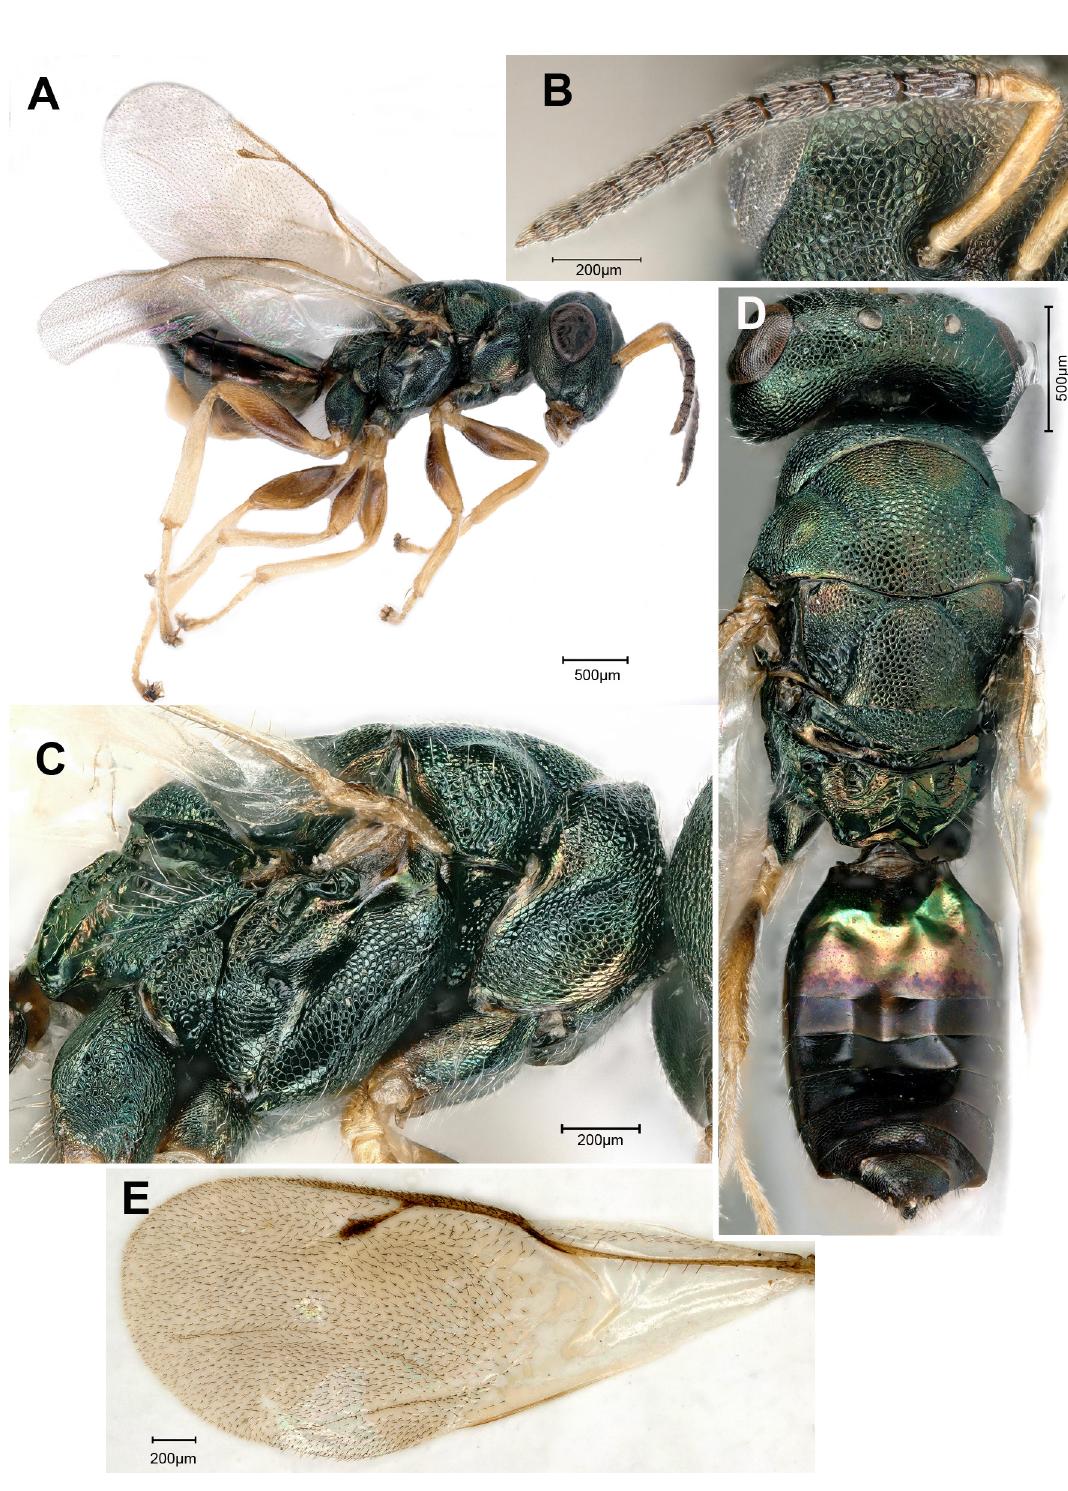
Fig. 15 . Stenomalina delvarei Lotfalizadeh & Rasplus sp. nov. A–C . Holotype, ♀ (HMIM). A . Lateral view. B . Antenna. C . Mesosoma in lateral view. D–E . Paratype, ♂ (HMIM). D . Dorsal view. E . Fore